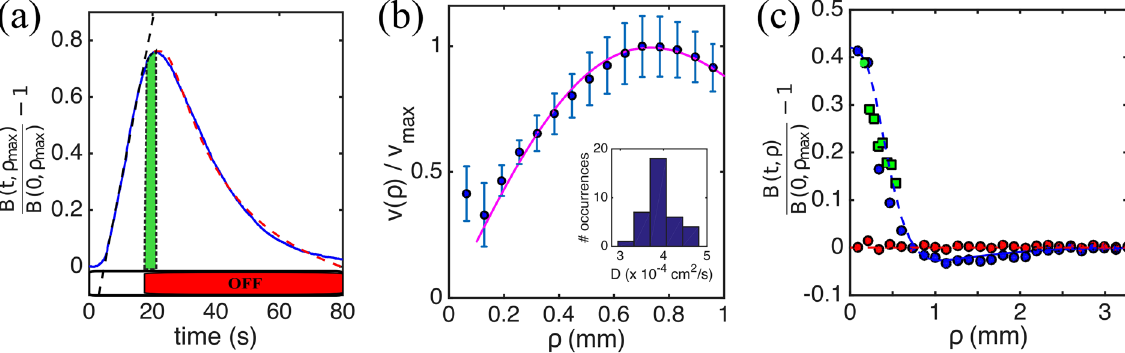
Figure 2. Steady phototactic response of a population of C. reinhardtii . ( a ) Representative phototactic accumulation curve at ρ = 958 μ m (blue solid line) as the phototactic light is turned on (at t = 0 s) and then off (at t = 15 s) as indicated by the coloured bars. Cells accumulate linearly (black dashed line: linear fit; slope 0.057% increase/s) and disperse diffusively (magenta dashed line: fit to diffusively spreading Gaussian). The green bar highlights the overshoot after light-off. ( b ) Average normalised phototactic velocity vs. distance from the fibre centre from 36 different cycles. Errorbars: standard deviation of the measurement set. Magenta solid line: normalised light intensity gradient. The experimental light intensity is represented here by its best Gaussian fit. Inset: Effective diffusivities D measured from 36 different Gaussian fits to the dispersal curves. ( c ) Radial concentration profiles from population experiments. Red circles: without light stimulus; blue circles: 35 s after light-on; green squares: concentration profile estimated using individual tracks from single-cell experiments; dashed blue line: one-parameter fit to the continuum model, giving h * = 519 ± 27 μ